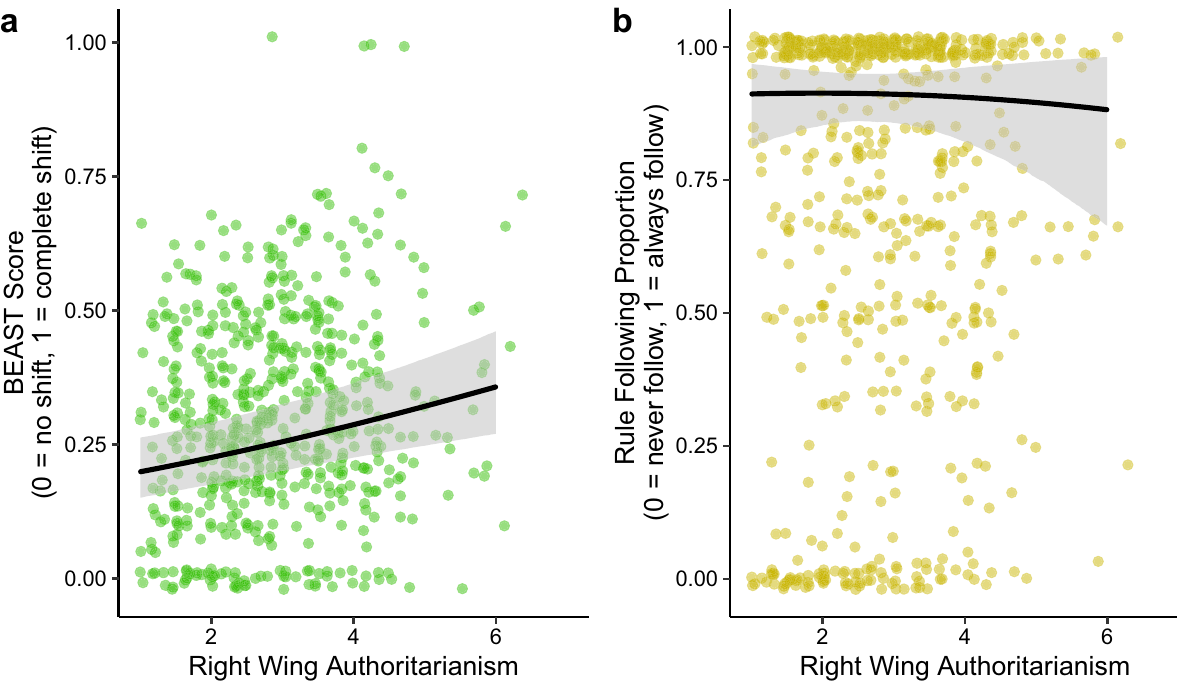
Figure 4. Right Wing Authoritarianism positively predicts social information use in the BEAST ( a ) but does not predict rule following in the Rule Following Task ( b ). Lines are mean posterior regression lines from Bayesian multilevel models without demographic covariates, shaded areas are 95% credible